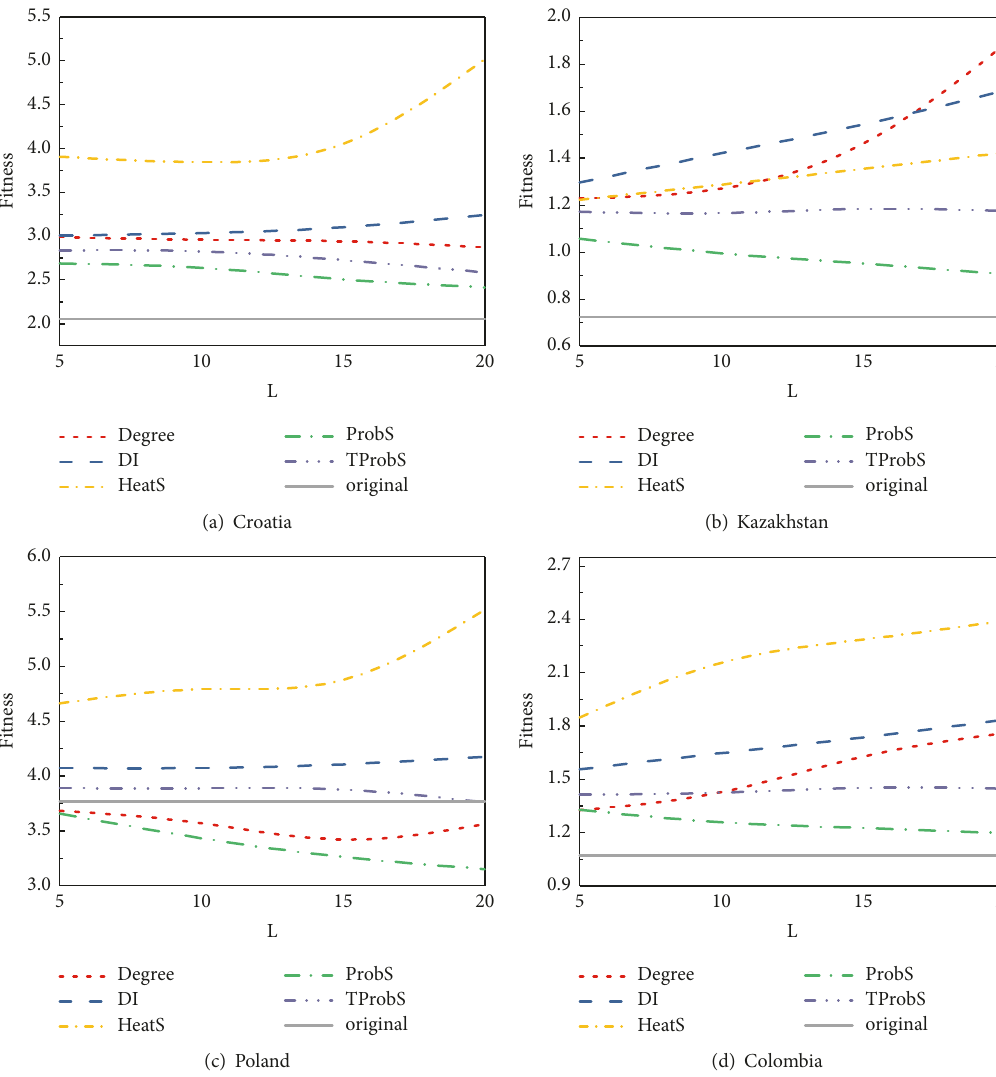
Figure 4: Detailed view of the fitness as a function of the length of the recommendation list 𝐿 for four randomly selected countries. The original fitness values of four countries Croatia, Kazakhstan, Poland, and Colombia are 2.0563, 0.7234, 3.7678, and 1.0714,